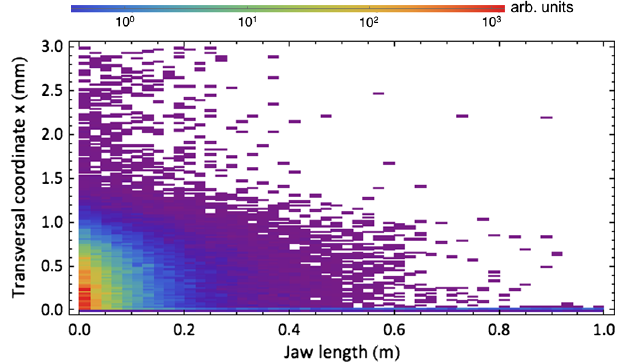
FIG. 17. Density of inelastic interactions in the TCTH.4R5.B2 jaw for Case 3. Simulated losses concentrate in the left jaw, therefore the right one is neglected in the plot. A bin size of 2 cm in s and 20 μ m in x is used. Losses are integrated along y . In this case, the collimator half gap in millimeters, 11.9 mm, has been already subtracted to the transversal coordinate, so the edge of the jaw is set at x ¼ 0 .